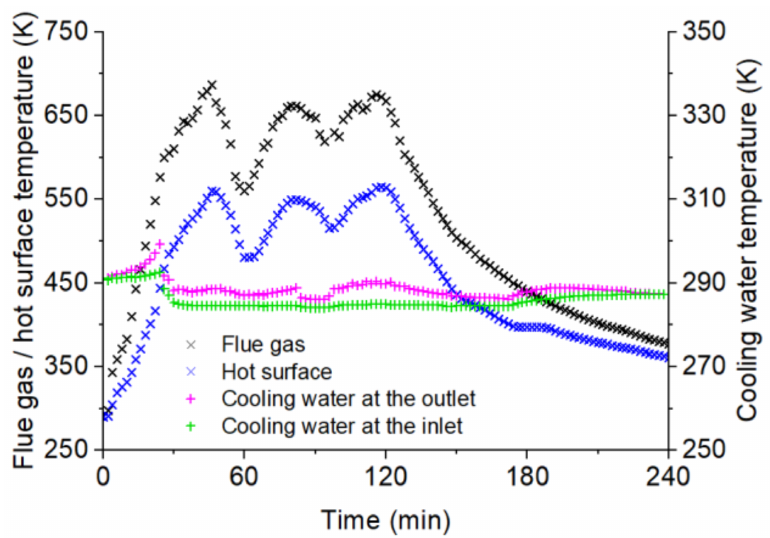
Figure 13. Variations in the temperature of the flue gas, the temperature of the hot surface, and the temperature of the cooling water during the combustion process (when TEG No. 5 was tested).